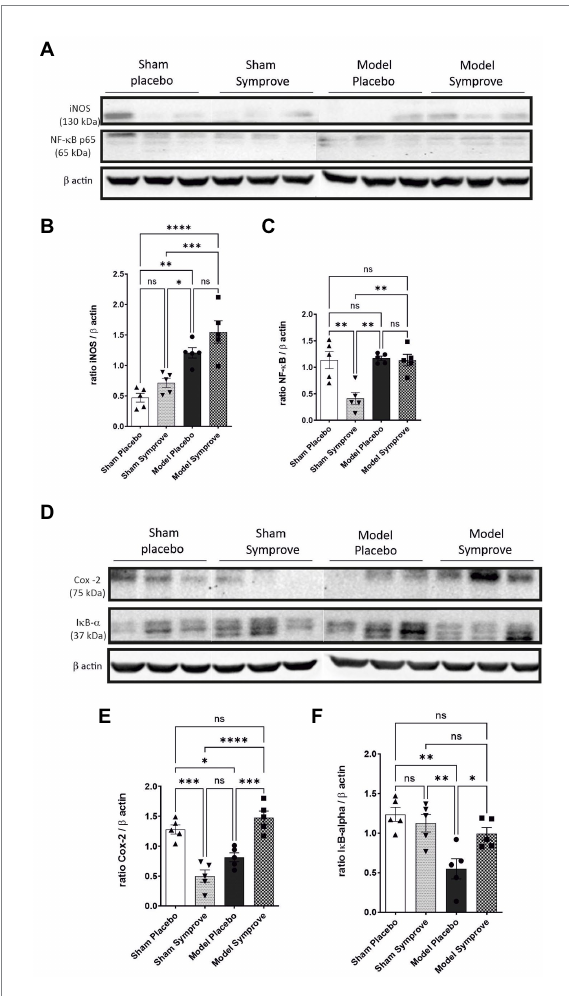
FIGURE 4 Effect of Symprove ™ on inflammatory parameters in the small intestine of the 4 experimental groups ( n = 3 per group displayed): Sham + placebo, Sham + Symprove ™ , model + placebo and model + Symprove ™ . (A) Western blot examples of iNOS and NF- κ B levels. (B,C,E,F) Group comparisons in the expression levels of inflammatory markers denoting an increased inflammatory response in the model group and some prevention by Symprove ™ treatment. (D) Western blot examples of COX-2 and I κ -B α levels. Data are displayed as means ± SEM. * p < 0.05, ** p < 0.01, *** p < 0.001, **** p <